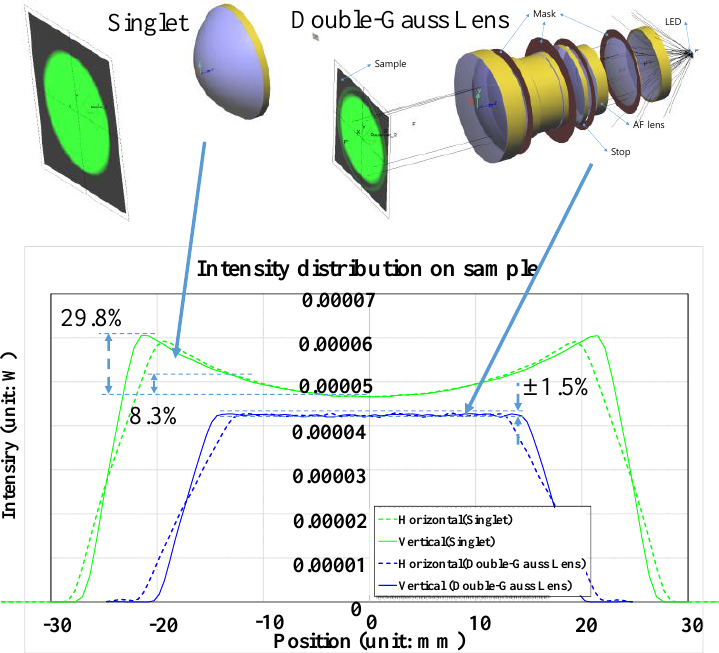
Figure 8. Optical layout and light intensity distributions of the single lens and our designed lens.